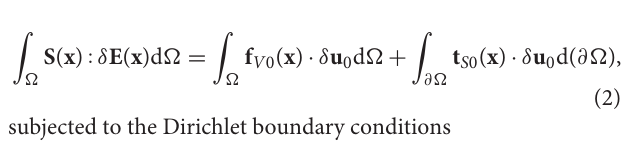
functional of the form (Bonet and Wood,